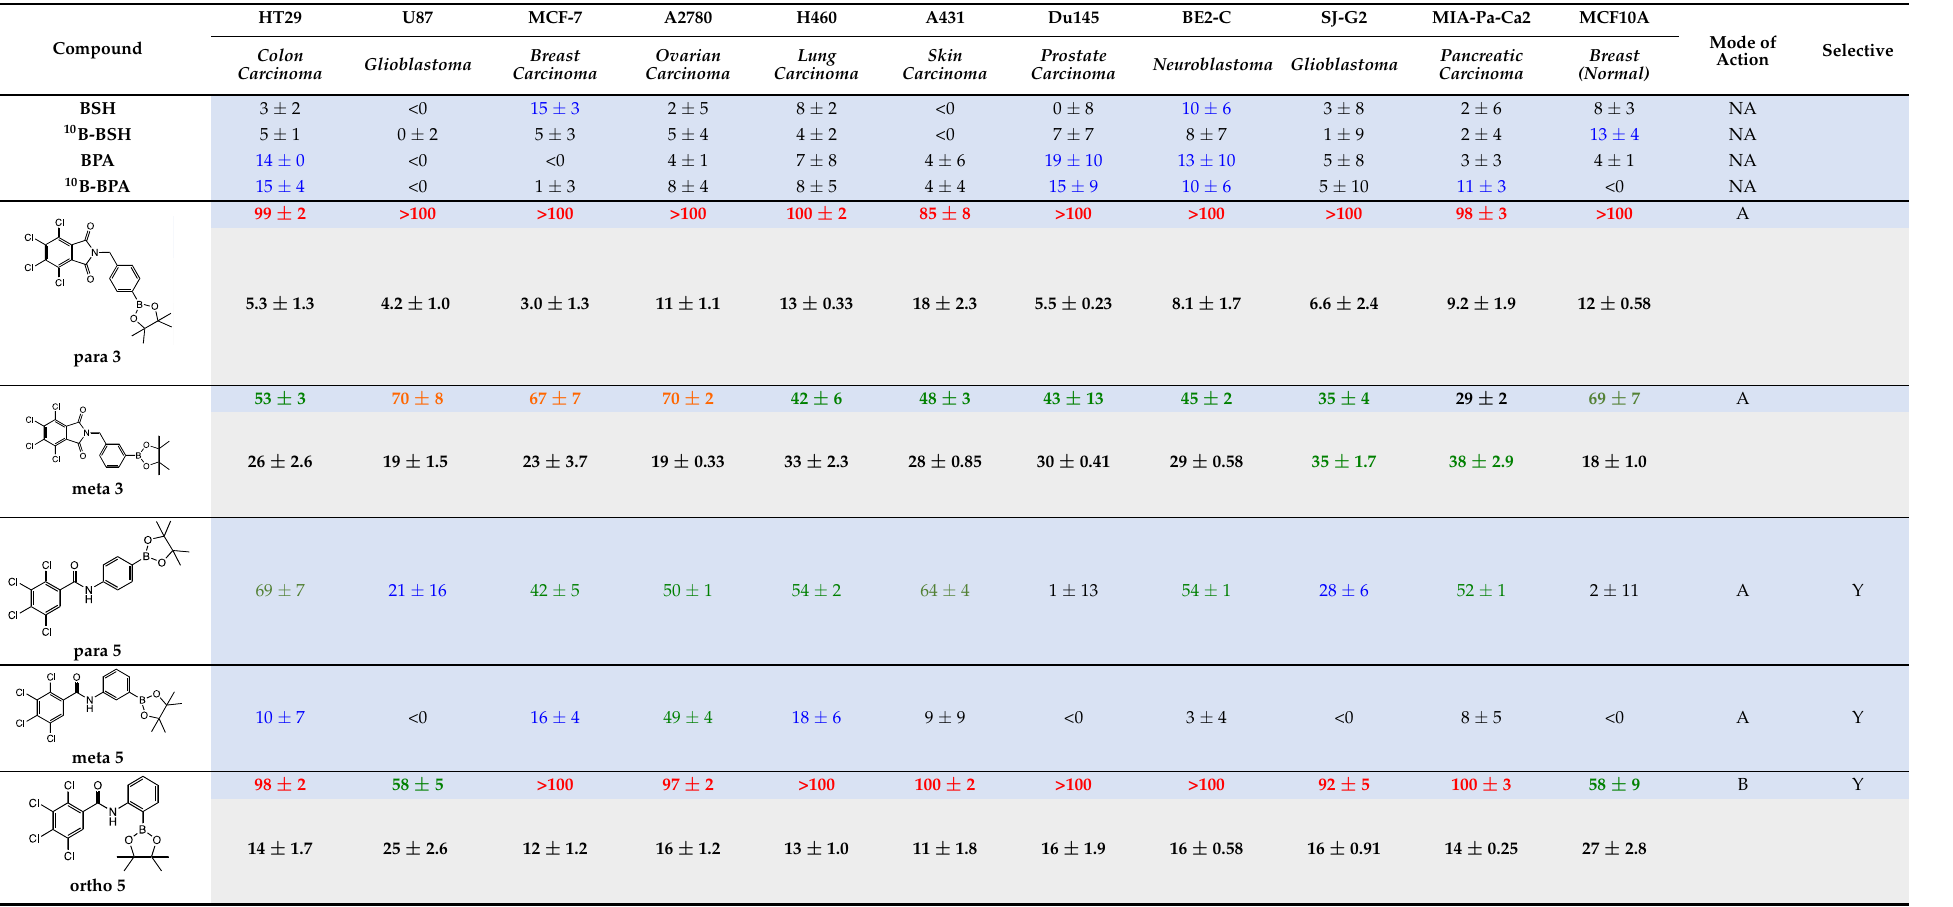
Table 3. Cancer Screening. On blue background DOSE SCREEN: Percentage (%) Cell Growth Inhibition in response to 25 µ M of Drug (the higher the value the greater the growth inhibition) and inhibition value ranges: 80–100% (red), 60–79% (orange), 35–59% (green), 10–34% (blue) and 0–9% (black). On green background DOSE RESPONSE: GI 50 = Concentration ( µ M) that inhibits cell growth by 50% (the lower the value the greater the growth inhibition). In bold are highlighted the values of the three most potent drugs.